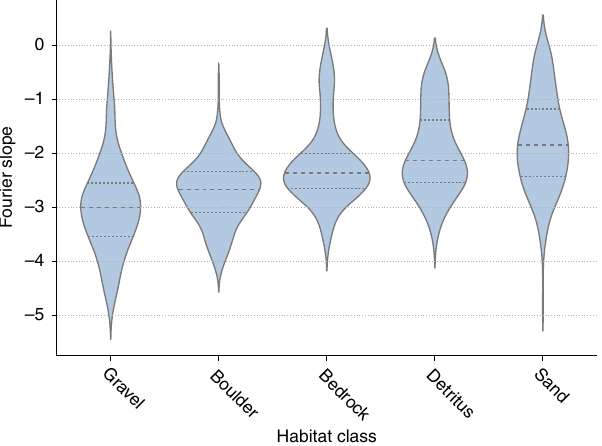
Fig. 3 Distribution of Fourier slopes for images of fi ve habitat classes. Dashed lines represent the median for each group, and dotted lines represent the interquartile range. Shaded areas represent the kernel-density estimate for each habitat class. A total of n = 597 habitat images were used to represent all habitat types. Each image was subsampled twice for a total sample of n = 1194